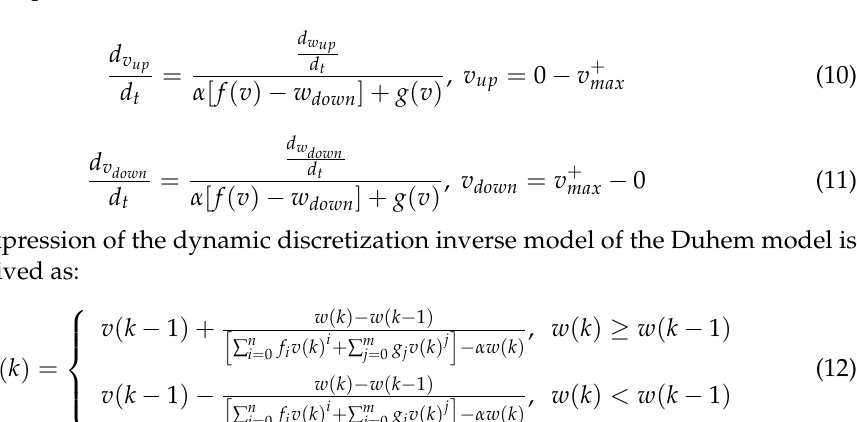
Figure 15. Signal fitting error plot (40 Hz): ( a ) ascending segment; ( b ) descending segment.